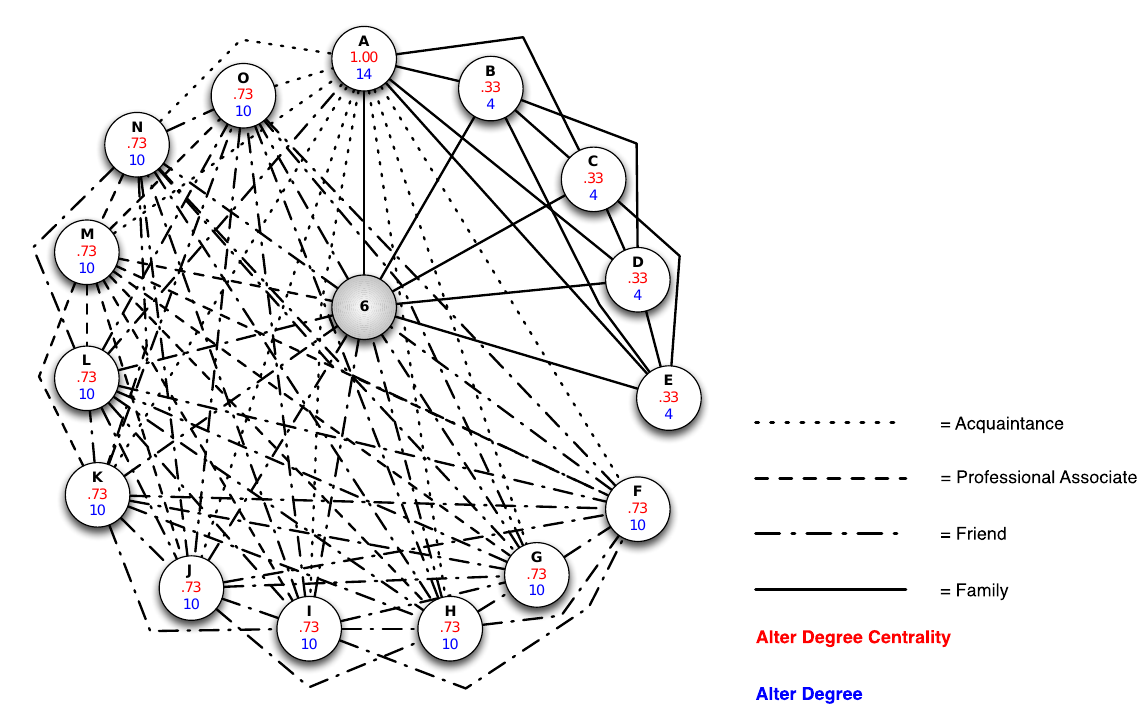
Source: Scott (2016).